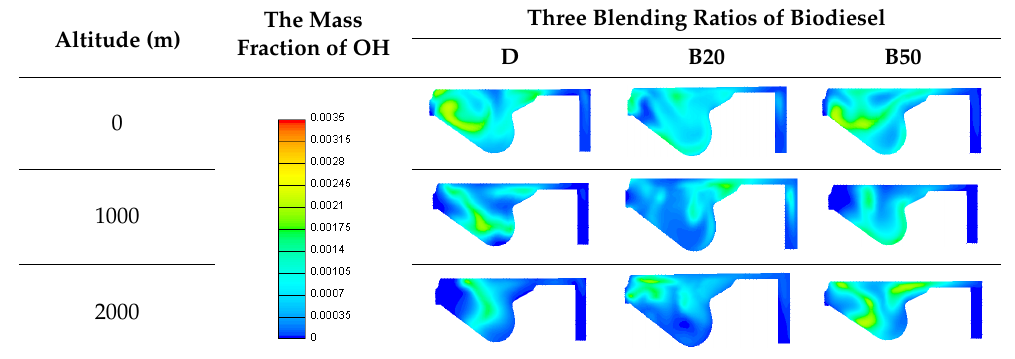
Table 3. Effect of different plateau environments on OH distribution field of cylinder with three blending ratios.